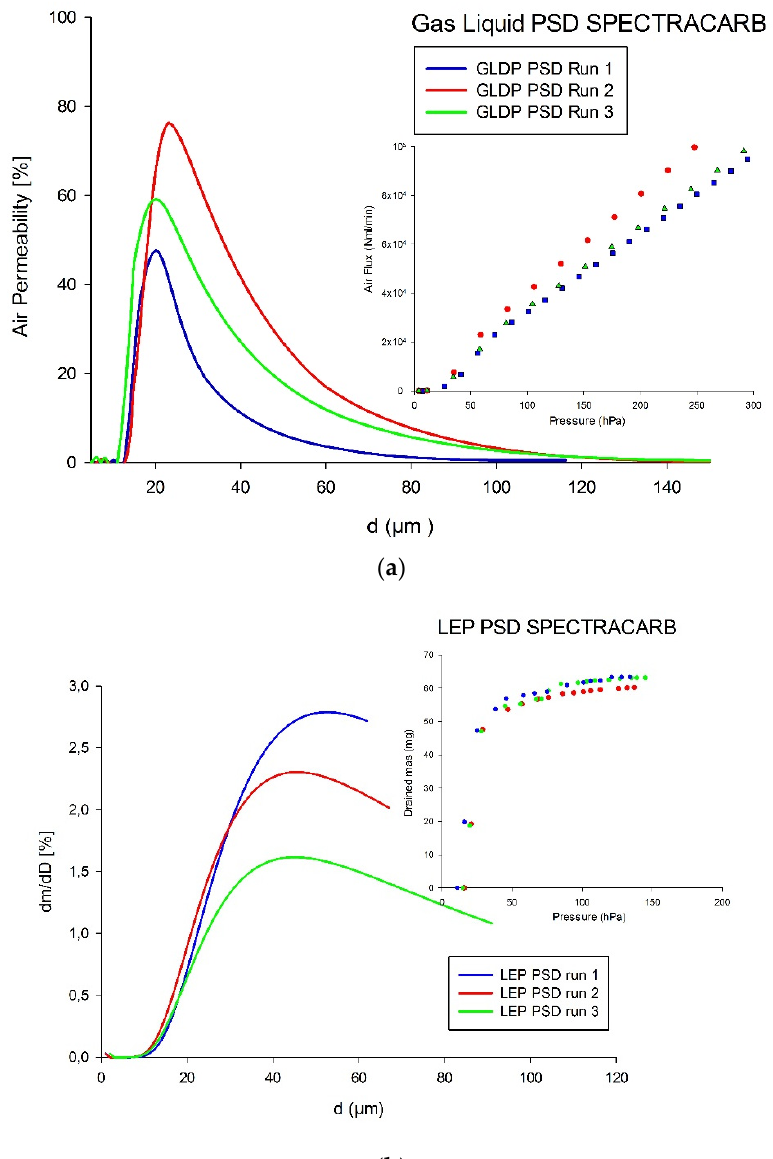
Figure 4. Experimental curves and resulting PSDs of SPECTRACARB GDL by ( a ) GLDP; ( b ) LEP.